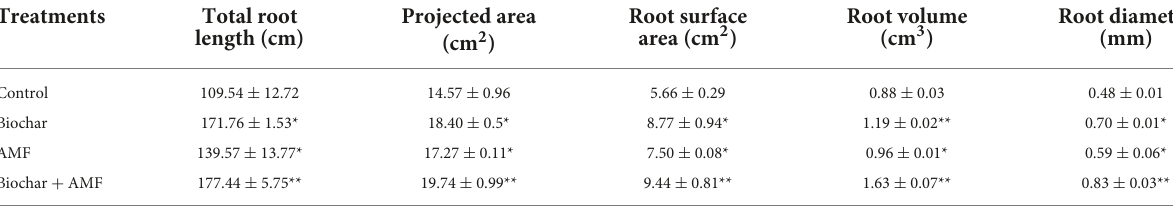
Dataaremeansofthreereplicates( n =3).Asteriskdifferedsignificantlyat* P < 0.05,** P < 0.01,*** P < 0.001.